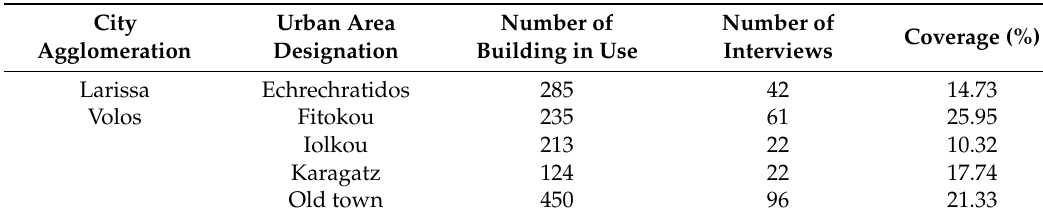
Table 2. Number of buildings in which interviews have been conducted for five urban areas in the cities of Larissa and Volos,